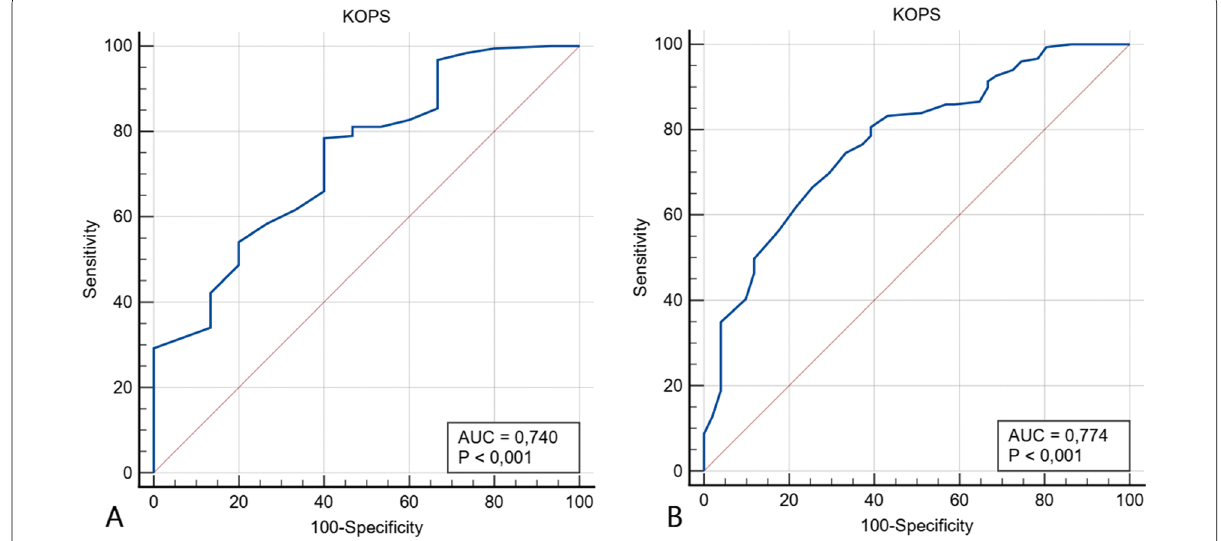
Fig. 1 Graphical analysis of the area under the ROC curve based on Kellgren and Lawrence degrees